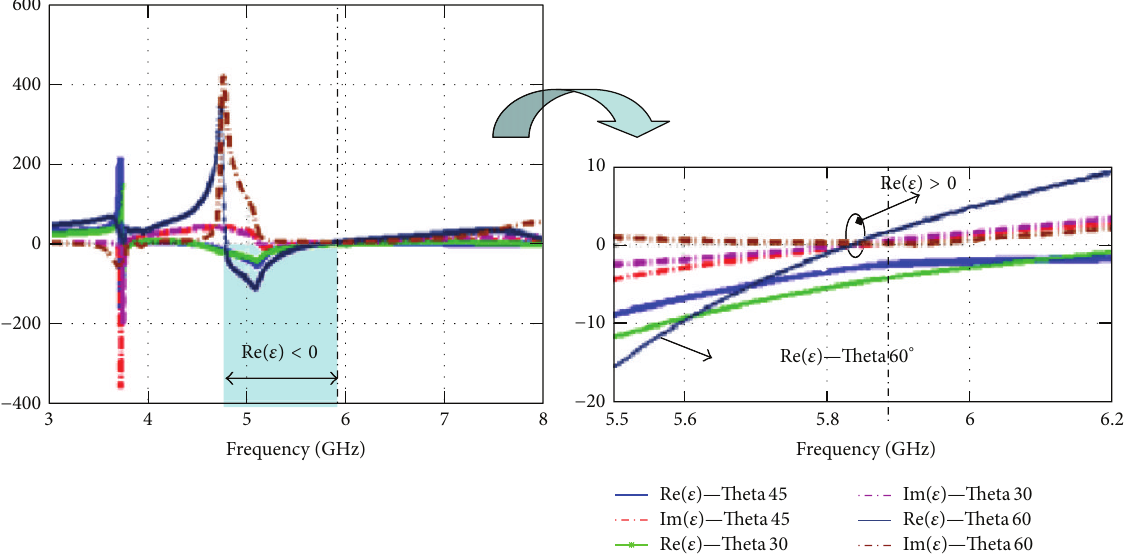
Figure 11: Effective permittivity values are obtained with varying incident wave.